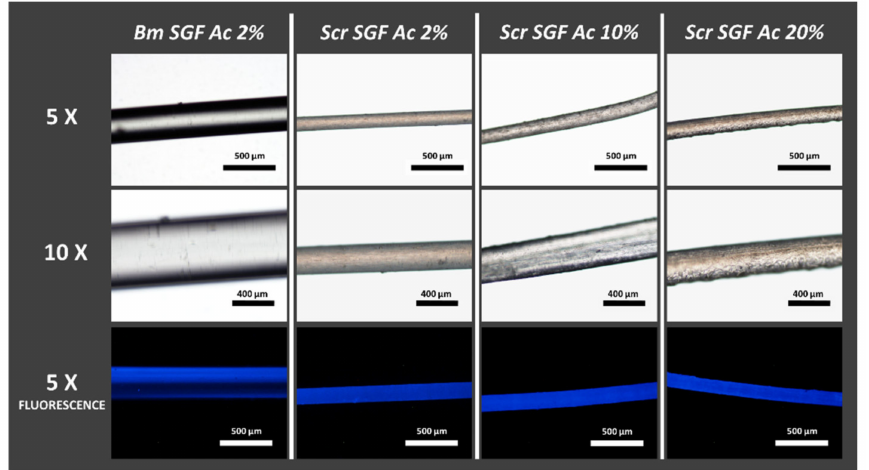
Figure 1. Micrographs of SGFs produced from silk glands of S. c. ricini (Scr SGF) under different experimental conditions and from B. mori (Bm SGF). The abbreviations Scr SGF Ac 2%, Scr SGF Ac 10% and Scr SGF Ac 20% refer to the fibres obtained from eri silkworms, using acetic acid dissolutions at 2%, 10% and 20% v / v , respectively, while those obtained from mulberry silkworm are named as Bm SGF Ac 2%. The images were acquired at different magnifications; 5 × (scale bar 500 µ m) and 10 × (scale bar 200 µ